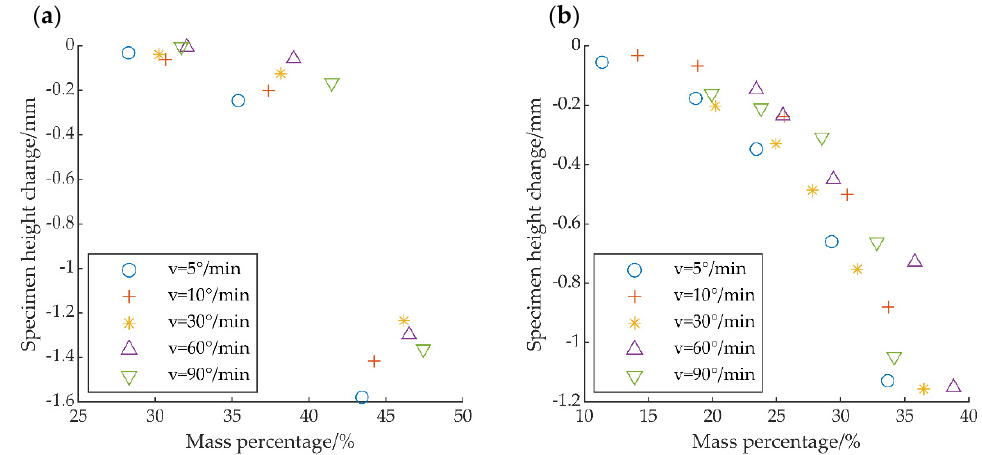
Figure 4. Degree of particle breakage versus system compression for ( a ) calcareous sand and ( b ) quartz sand.